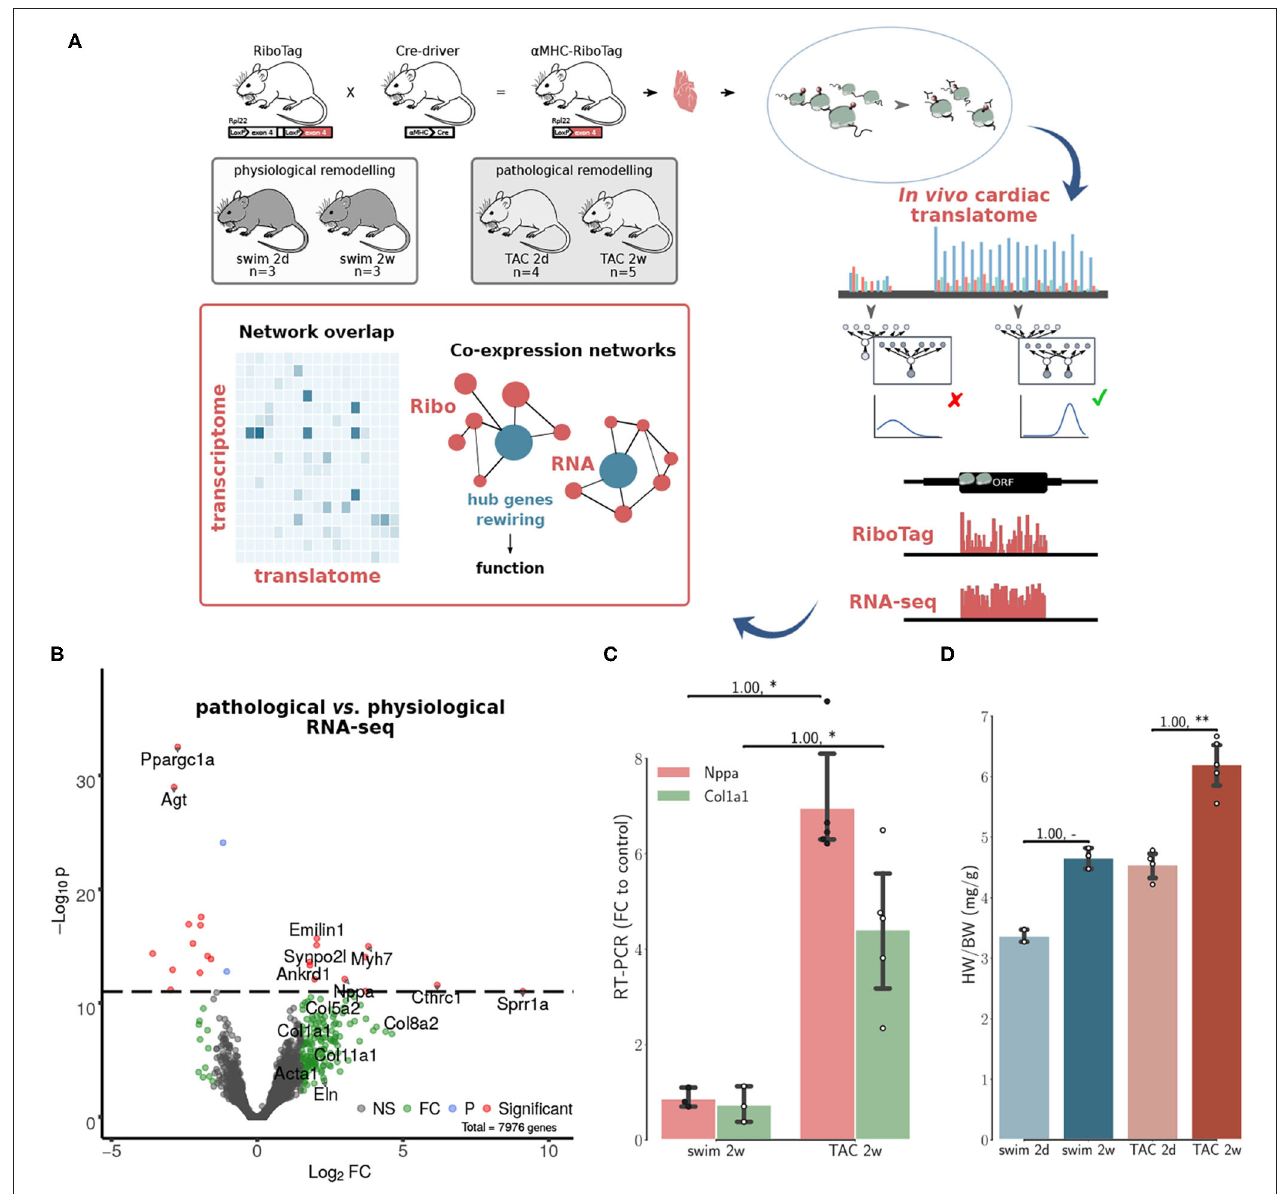
FIGURE 1 | Co-expression networks of transcriptional and translational regulation in cardiac remodeling. (A) The RiboTag system is used to find the cardiac translatome of 15 animals from two models at two time points. A final set of translated genes is inferred using graphical Bayesian models. Co-expression networks are then constructed separately for in vivo Ribo-seq (translatome from RiboTag data) and RNA -seq (transcriptome) data. The networks were used to identify hub genes associated with cardiac remodeling, and how changes in connectivity (network rewiring) are associated with differential functionality in transcriptome vs. translatome, see also Supplementary Figure 3 . (B) Volcano plot displaying the distribution of all genes with relative abundance (log 2 RNA -seq pathological vs. physiological) plotted against significance level, showing significantly increased and decreased genes during in vivo pathological stress. Top genes (red) are highlighted. A number of genes (green) significant at a threshold of 0.05 are also highlighted. NS, Non-significant; FC, Fold change only significant; P, p -value only significant; Significant, FC+P. (C) RT-PCR fold changes relative to control animals (2w) for two important markers of hypertrophy and fibrosis, corroborating evidence from RNA-seq shown in (B) . (D) Heart-weight-to-body-weight ratio (HW/BW) after 2d and 2w of exercise in the physiological model, 2d and 2w after transverse aortic constriction (TAC) surgery. For (C,D) , N ≥ 3 at each time point. Significance was measured using Mann–Whitney U -test, at a threshold of * < 0.05 (** < 0.01, p -values may be affected by the small sample size, for this reason we also report effect size using non-directional rank-biserial correlation). For (D) only, Kruskall–Wallis test H = 10.9, p = 0.01.